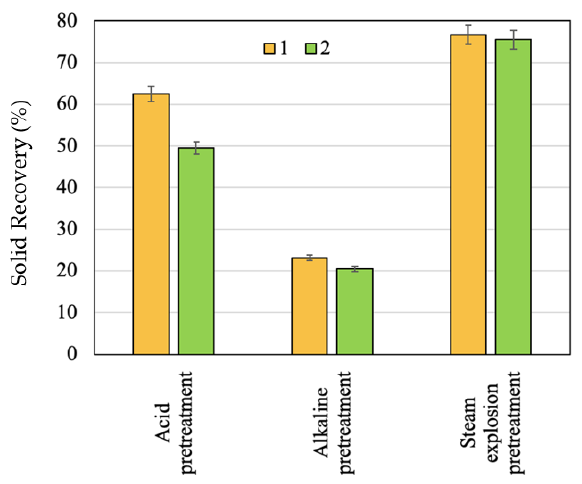
Figure 1. Effect of pretreatments on solid recovery: 1—apricot seed shells; 2—walnut shells.